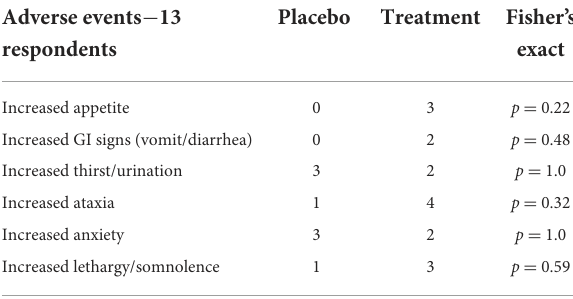
TABLE 4 Adverse event report at end of 12 weeks of CBD/CBDA-rich hemp oil vs. placebo treatment. Adverse events − 13 Placebo Treatment